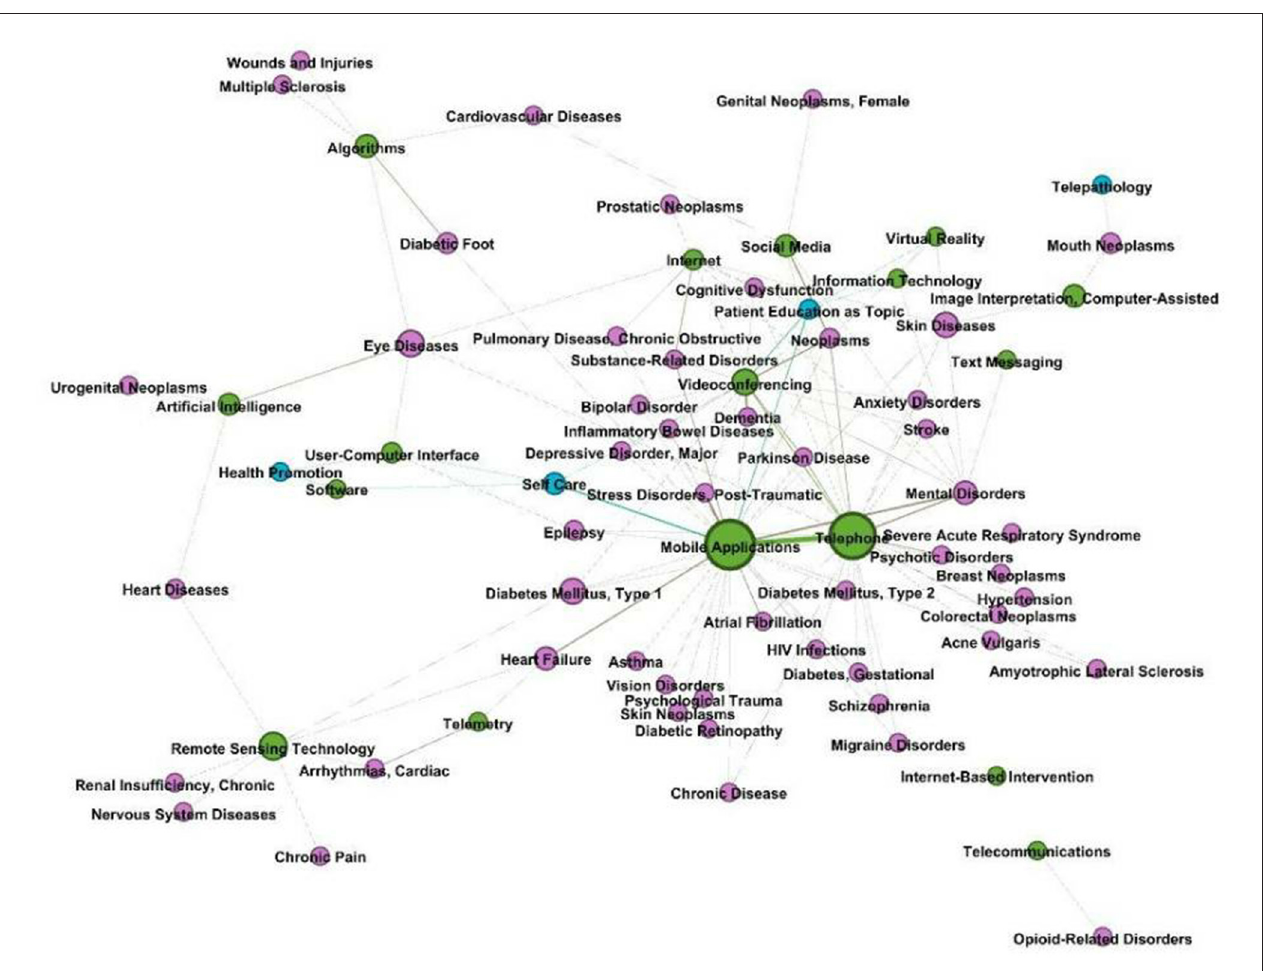
FIGURE 4 | Technology entity nodes and other node connections in the